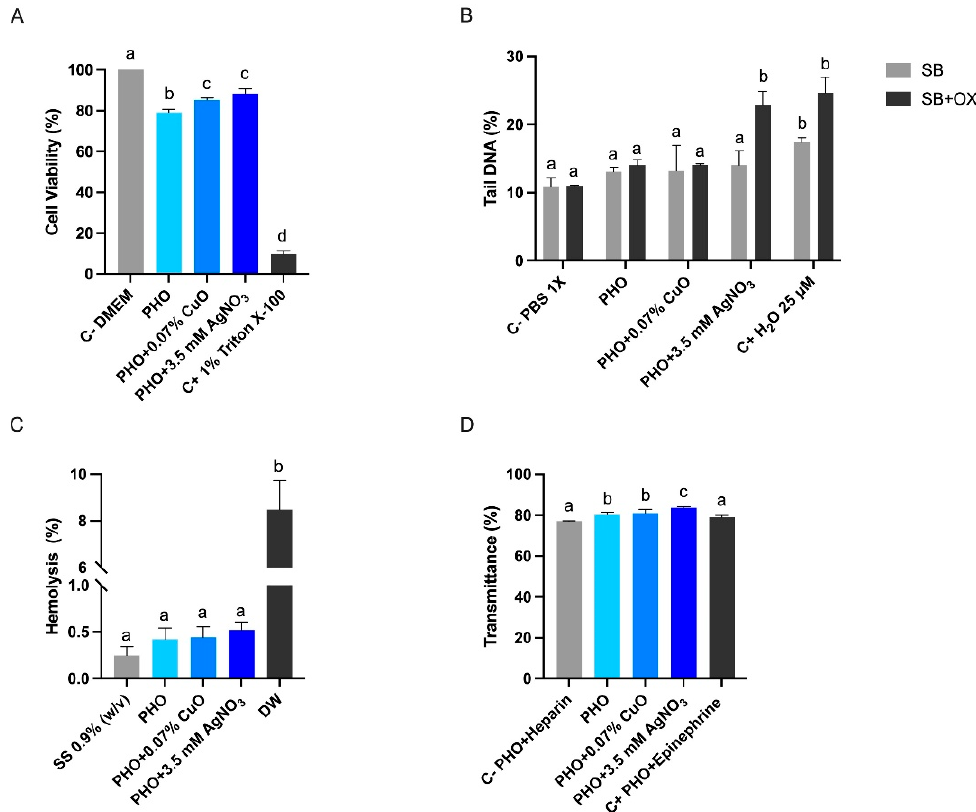
Figure 6. Biocompatibility of PHO active films. ( A ) viability test on HFF-1 cells after 24 h of exposure; ( B ) genotoxicity assay on HFF-1 cells after 3 h of exposure; ( C ) hemolysis caused by neat PHO films and bioactive PHO films; and ( D ) platelet aggregation of human plasma on active PHO and neat PHO films after 3 min of exposure. Mean values with different letters represent significant differences ( p < 0.05). C − (negative control), C+ (positive control), SS (saline solution), and DW (distilled water).